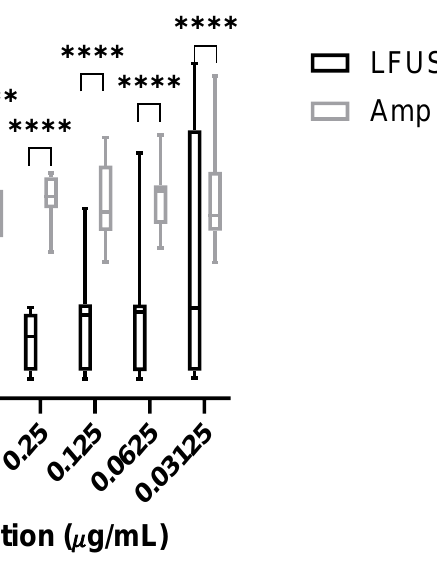
Figure 1. Effects of Amp B on the cell viability of R. oryzae biofilms with or without ultrasound treatment. This figure shows XTT absorption for varying concentrations of Amp B normalized to untreated controls. LFUS significantly enhances Amp B effects at concentrations of <1 µg/mL. (**** p > 0.0001).